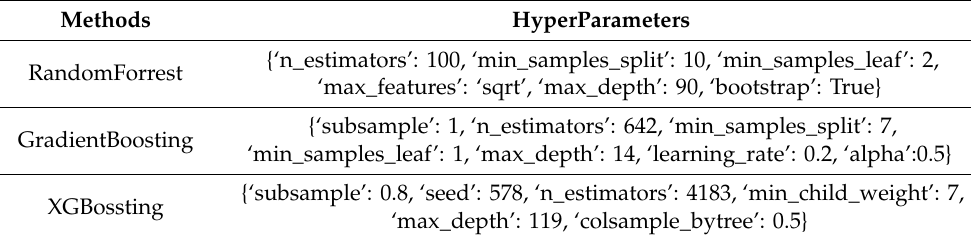
Table 2. HyperParameters used in each algorithm.